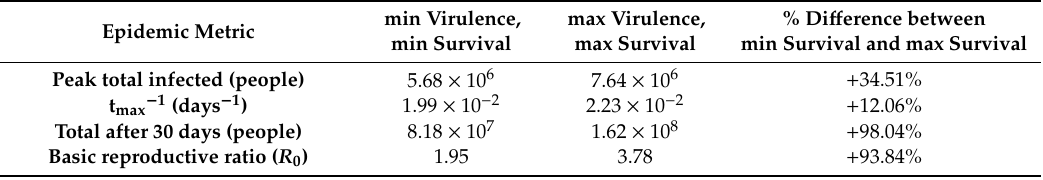
Table 5. Positive correlation scenario: comparing epidemic metrics under low survival / low virulence versus high survival / high virulence scenarios (as in the positive correlation scenario). For each metric analyzed, these are the heatmap values for the bottom left (at “coordinates” (Vir, Sur) → ( − 5%, − 5%)) and top right (at “coordinates” (Vir, Sur) → ( + 5%, + 5%))